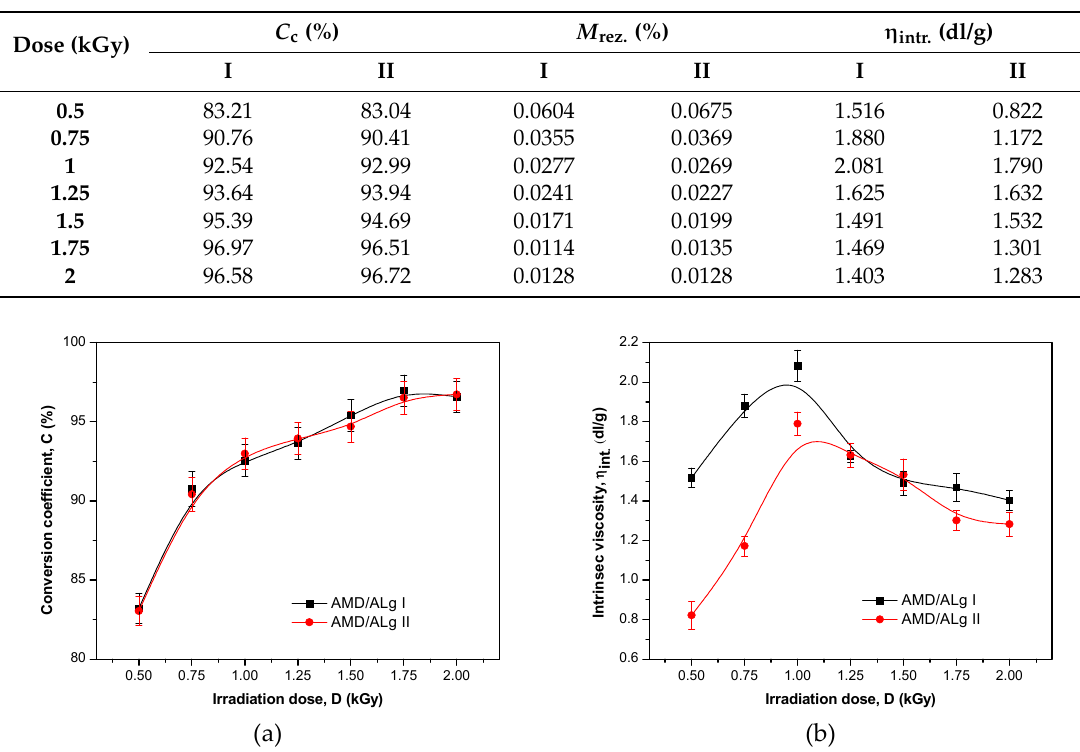
Table 3. Physical and chemical characteristics of sodium alginate- g -acrylamide polymers. AMD/ALg I (I) and AMD/ALg II (II).